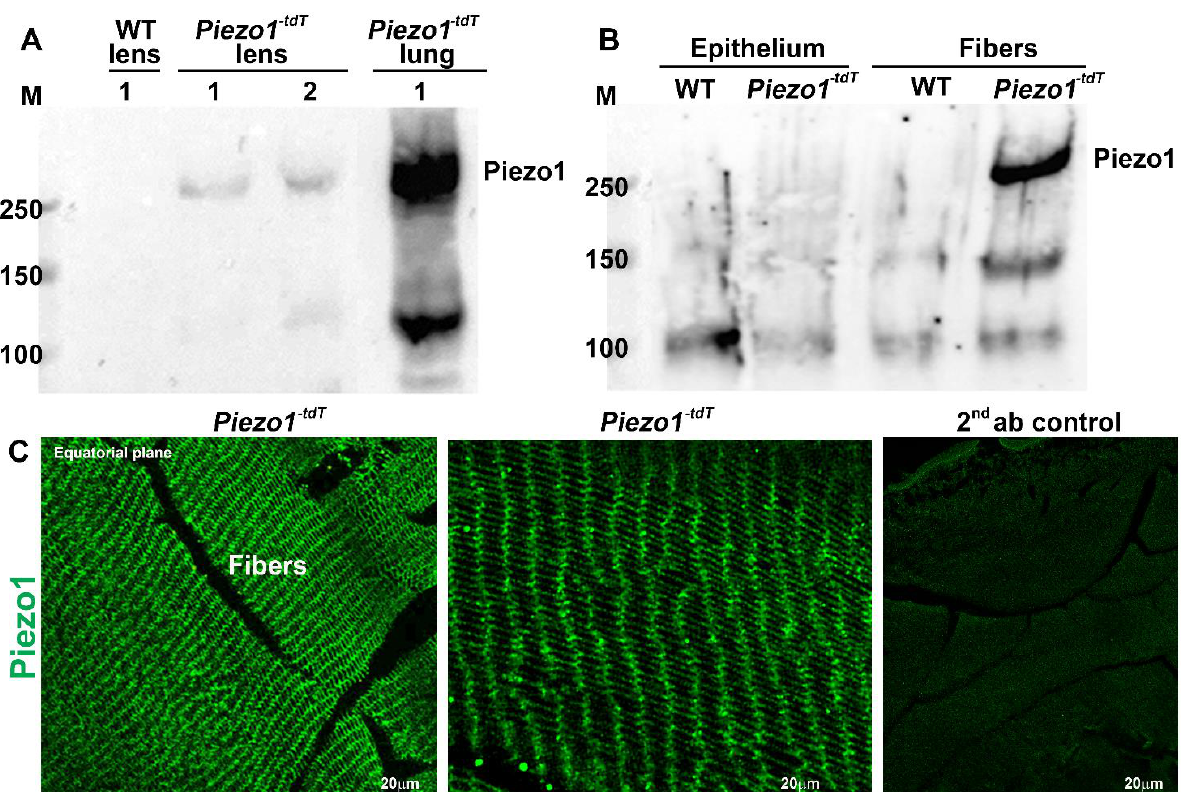
Figure 4. The piezo1 -tdT mouse confirms the expression and distribution of Piezo1 in lens fibers. ( A ). The Piezo1 -tdT mouse model expressing a fusion protein of Piezo1 and tdTomato (Piezo1 -tdT ) was used to determine the distribution pattern of Piezo1 in the mouse lens. Similar to what was found in the wild-type lenses (Figure 3), Piezo1 -tdT exhibiting the expected molecular mass of >250 kDa was detected only in P30 lens homogenates derived from the Piezo1 -tdT mice, but not in the wild-type lens. The positive control (lung tissue lysate from the Piezo1 -tdT mice) also showed a robust expres- sion of Piezo1 -tdT . Lanes 1 and 2 represent two different loads of the total protein (75 and 150 µg, respectively). ( B ) The Piezo1 -tdT fusion protein was detected predominantly in fiber cell lysates com- pared to lenses’ epithelial lysates. ( C ). Immunofluorescence analysis revealed the Piezo1 -tdT fusion protein distributing to lens fibers with localization to both the short and long arms of the hexagonal lens fibers (Left and middle panels are with low and high magnification, respectively). The right panel shows a second antibody (Alexa Flour 488) background control fluorescence staining in the Piezo1 -tdT mouse lens section. Bars: Image magnification.